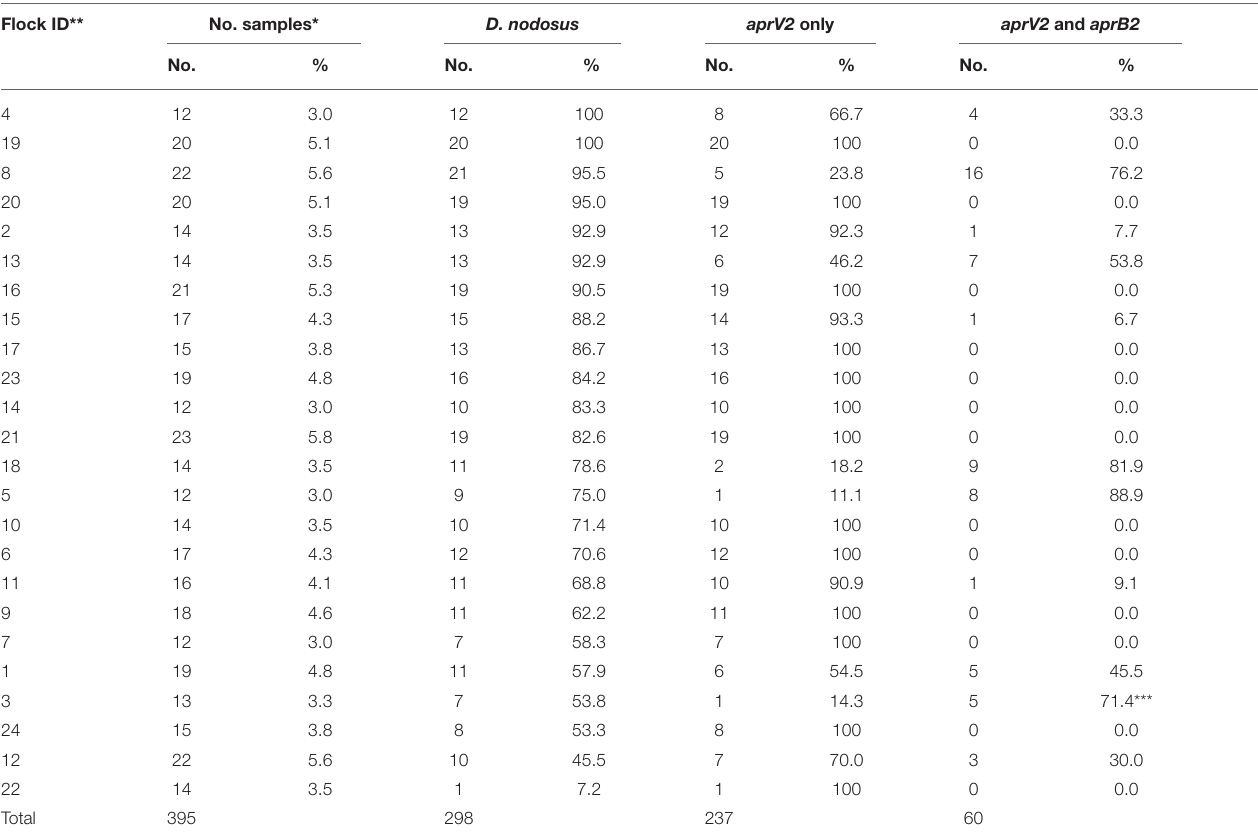
TABLE 3 | Number and percentage of samples collected and positive for Dichelobacter nodosus, aprV2 only and both aprV2 and aprB2 for 24 flocks in England with clinical footrot. Flock ID** No.